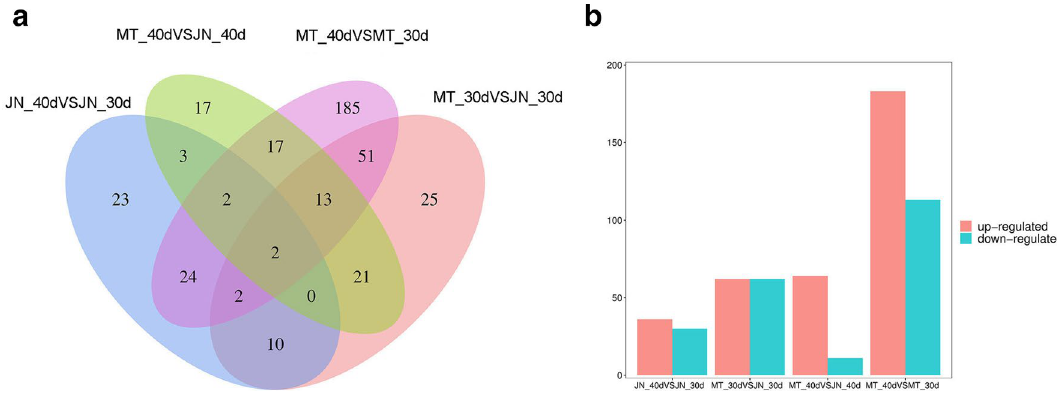
Figure 6. Differentially expressed lncRNAs in soybean. Venn diagrams showing the number of common and specific lncRNAs in comparisons among the four libraries. ( a ) Venn diagram of differentially expressed lncRNAs. ( b ) Regulation of differentially expressed lncRNAs in four different